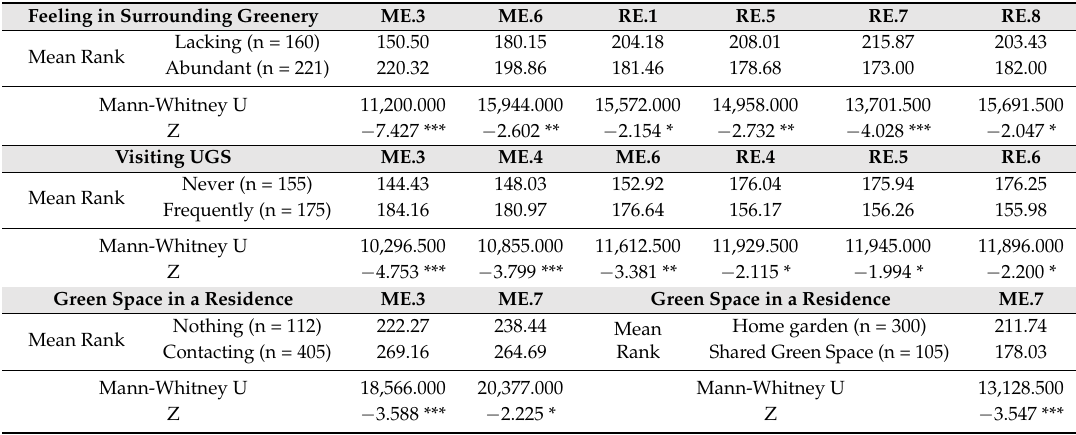
Table 4. Mann-Whitney U test results of exposure to urban green space. Table 4. Mann ‐ Whitney U test results of exposure to urban green space.